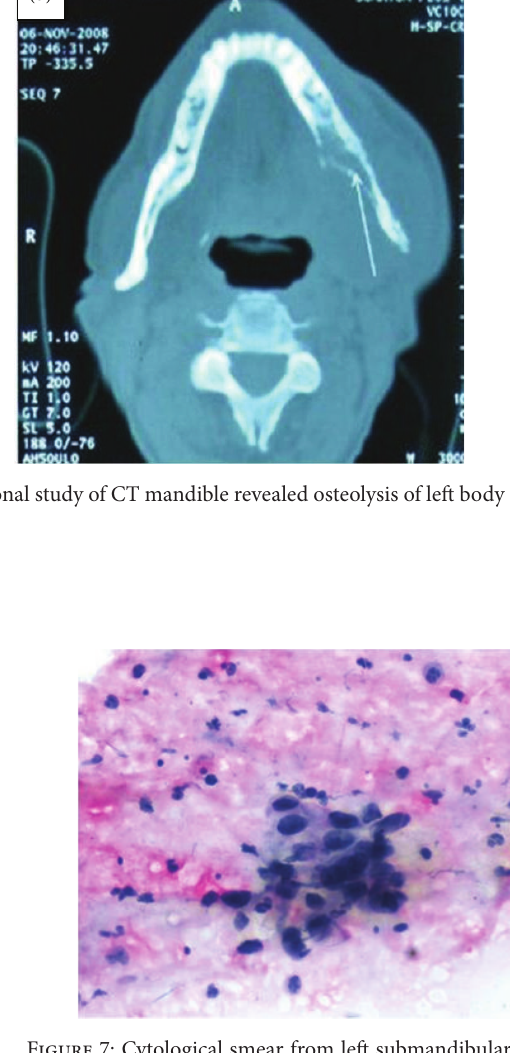
Figure 5: Histopathological picture revealing features suggestive of squamous cell carcinoma.